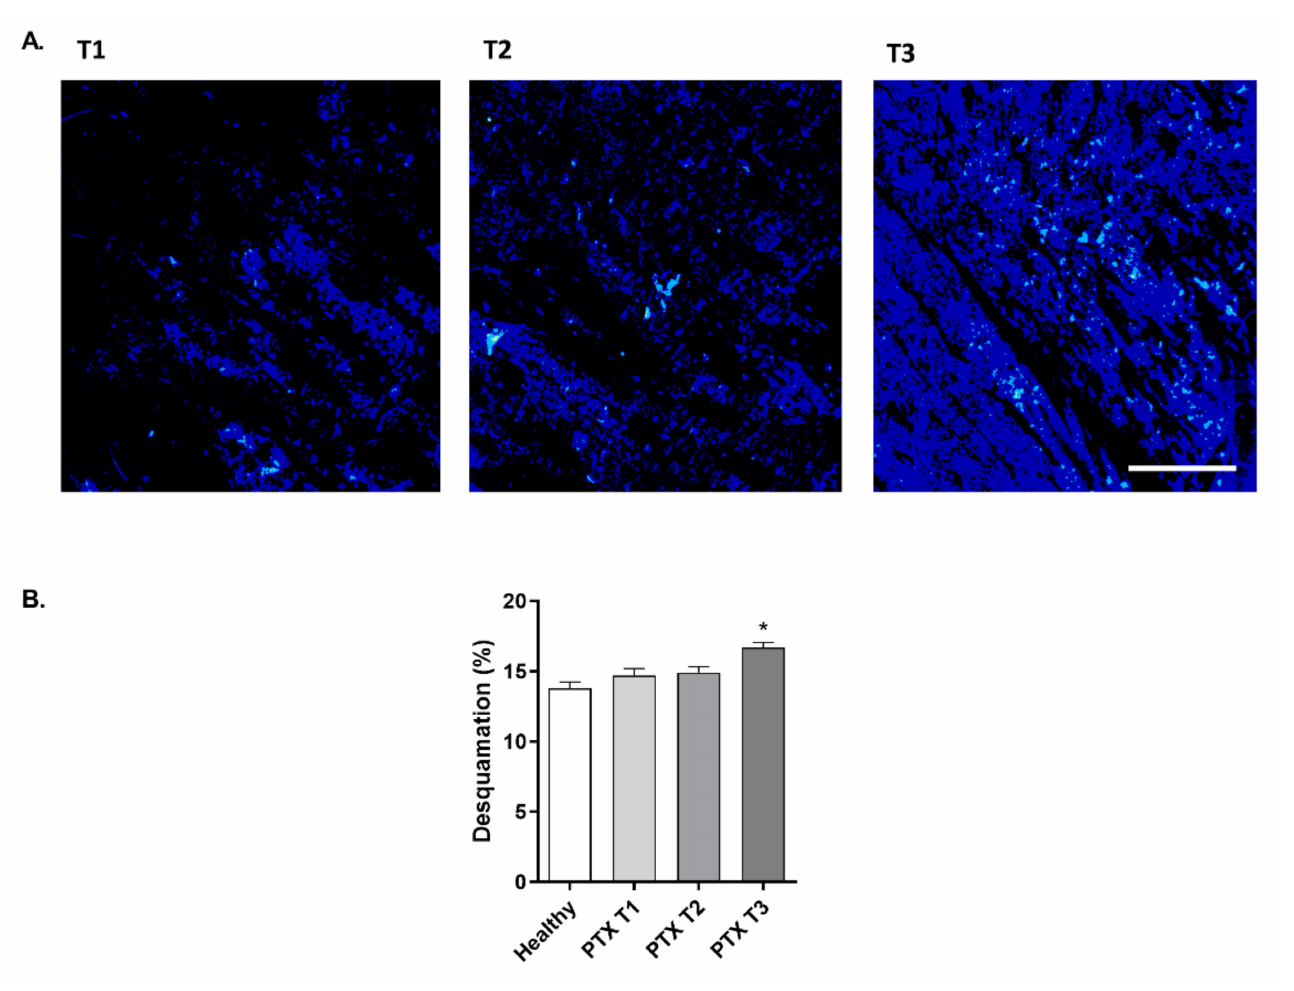
Figure 5. Paclitaxel increases the skin desquamation levels in oncologic patients. ( A ) Representative Corneofix ® tape images obtained before (T1), during (T2), and after (T3) treatment with paclitaxel. Images were obtained with the Visioscan ® probe. The blue color on the image represents higher desquamation levels. Scale bar 1 mm. ( B ) Skin desquamation percentage was measured in 20 onco- logic patients after PTX treatment at T1, T2, and T3 timepoints and in 20 healthy subjects as a control group. Measurements were conducted on the forehead with the combination of the Corneofix ® tape and the Visioscan ® probe. Results are expressed as the mean ± standard deviation of at least 3 measurements each time ( n = 20); * p < 0.05 vs.